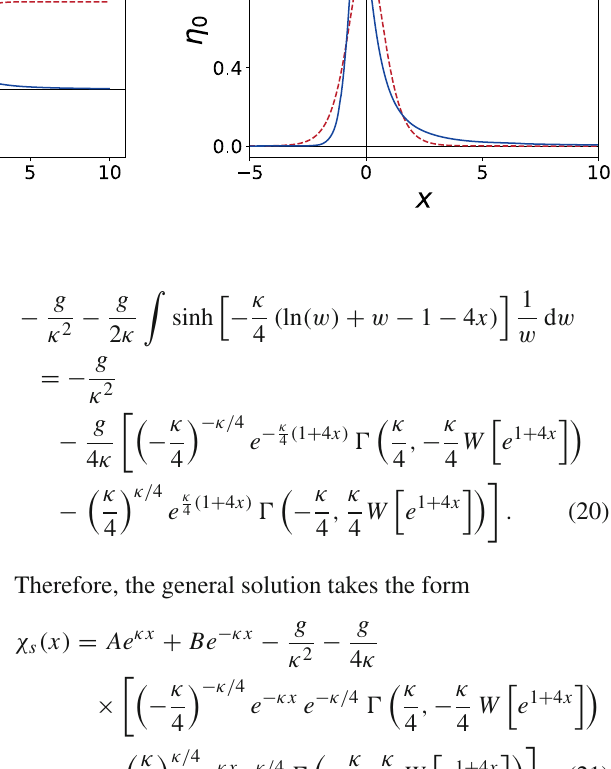
Fig. 2 a Stability potential. b Zero mode. In both cases, the solid line (blue) and the dashed line (red) show the graphs for our model and the kink of φ 4 theory,